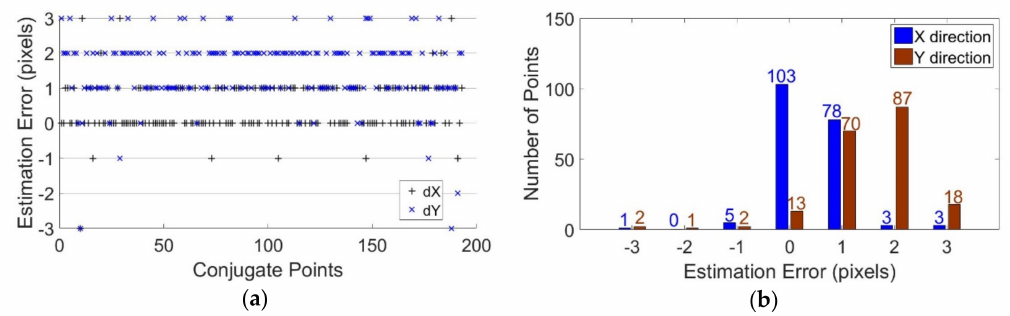
Figure 14. Estimation accuracy for approximate positions of conjugate points at the original image resolution level: ( a ) scatter chart; and ( b ) histogram chart.